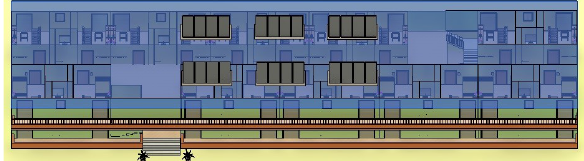
Figure 5. The internal furnished spaces of the